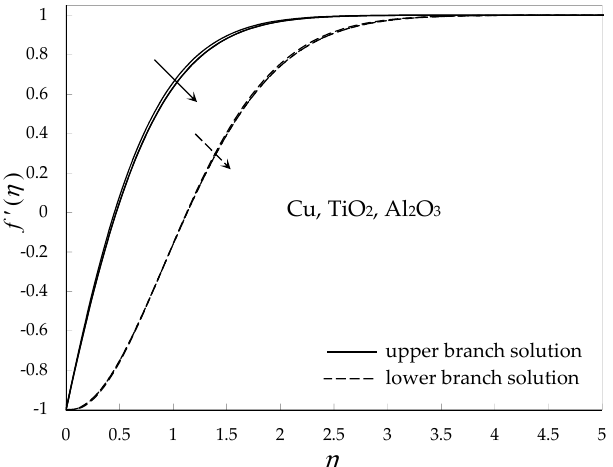
Figure 18. Velocity profiles 𝑓′(𝜂) for Cu-water, Al 2 O 3 -water and TiO 2 -water nanofluids when 𝜙 = 0.01, Nr = 0.1, K = 0.1, s = 1, c = − 1 and 𝜆 = − 2 (opposing flow).